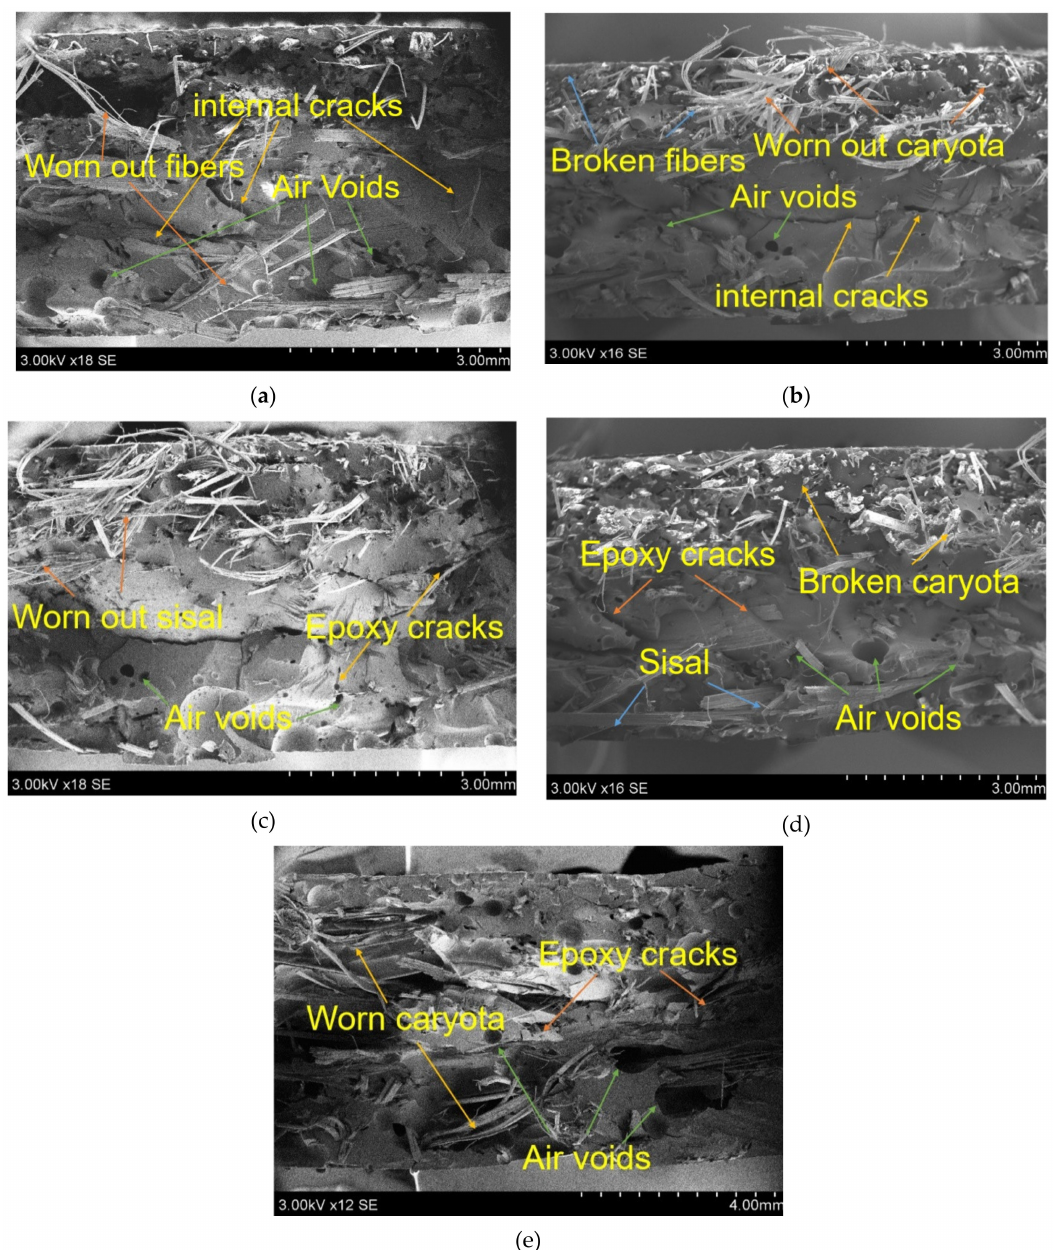
Figure 15. SEM images for fractured composites of flexure test specimens ( a ) 0C/40S, ( b ) 15C/25S, ( c ) 20C/20S, ( d ) 25C/15S, ( e )